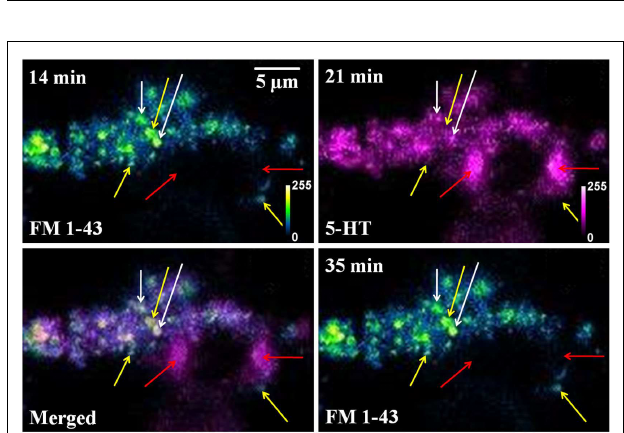
FIGUREA2 | FM 1-43 and serotonin co-localization is not caused by cross-talk between fluorescence channels. FM 1-43 (blue green) and Serotonin (5-HT, magenta) images of the same cultured serotonergic neuron. In the merged image (FM 1-43, 14min and 5-HT, 21min) white arrows show co-localized vesicular structures (recycled vesicles), yellow arrows mark spots visible only in the FM 1-43 channel, and red arrows mark spots visible only in the serotonin channel. FM 1-43 images recorded before (14min) and after (35min) serotonin imaging shows the same bright spots (by yellow arrows), but these are absent in the serotonin channel (5-HT, 21min).Top left corner of each image shows the starting time of image recording following sham treatment (Intensities false are color coded).